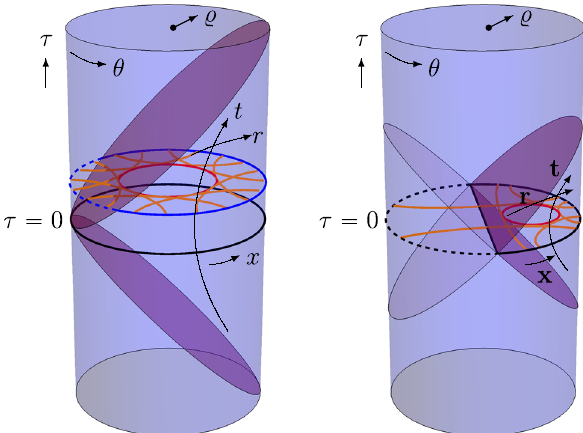
Fig. 2 Each of these solid cylinders is a Penrose diagram for AdS 3 , covered in full by the global coordinates ((cid:8),τ,θ) , but only in part by the Poincaré coordinates ( t , x , r ) on the left, or the Rindler coordinates ( t , x , r ) ontheright. a GenericspatialbulkcurvesinthePoincaréwedge (suchasthecircleshowninred)havesegmentswhosetangentgeodesics (shown in orange) are not fully contained within the wedge. In spite of this, a variant of hole-ography that employs ‘null alignment’ allows their reconstruction with entanglement entropies in the CFT [48]. b A Rindler wedge covers a smaller portion of global AdS, and in particular, it does not contain a full Cauchy slice. A priori, it is not clear if the ‘null alignment’ variant of hole-ography is sufficient to reconstruct arbitrary bulk curves within the Rindler wedge (such as the circle shown in red)